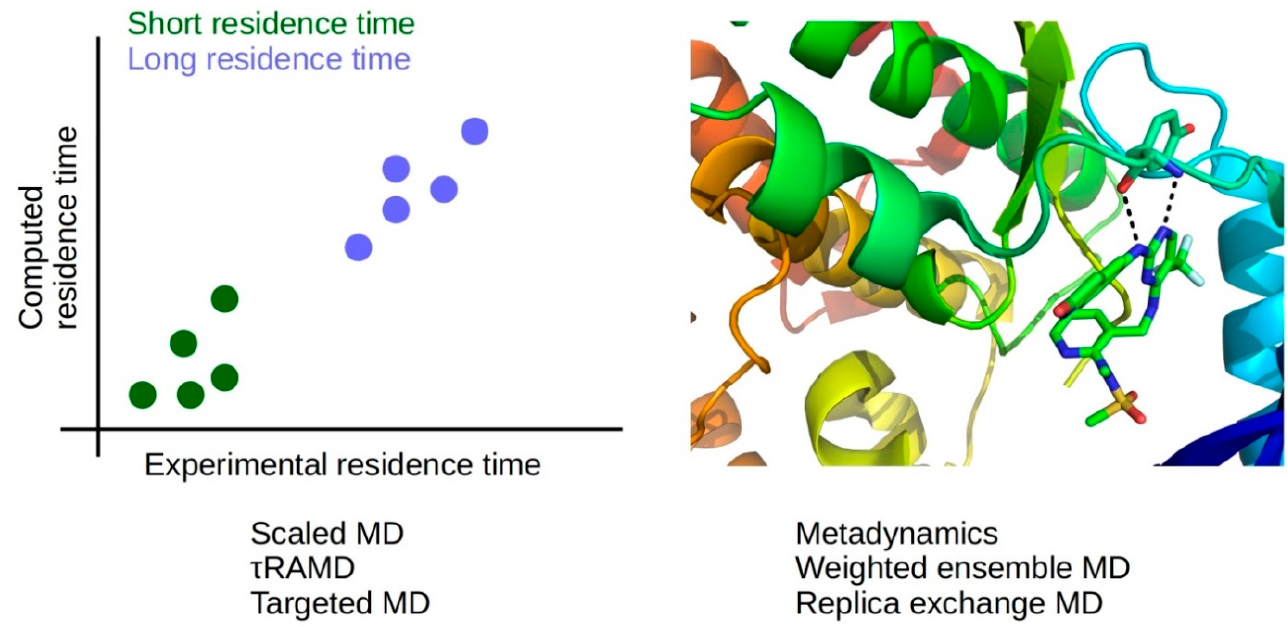
Figure 8. Methods of low computational cost (scaled MD, τ RAMD, targeted MD) allow the prediction of relative residence times (left panel), while methods of high computational cost (metadynamics, weighted ensemble MD, replica-exchange MD) provide information about drug-protein interactions during association and dissociation, which may be modified to modulate binding kinetics (right panel); ligand-protein complex from PDB ID 5TOB [303].